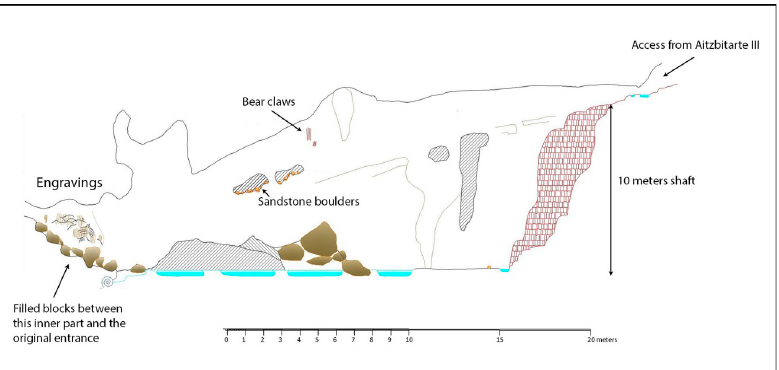
Fig 12. Plan of Aitzbitarte IX. The decorated area is indicated (J. Busselo).